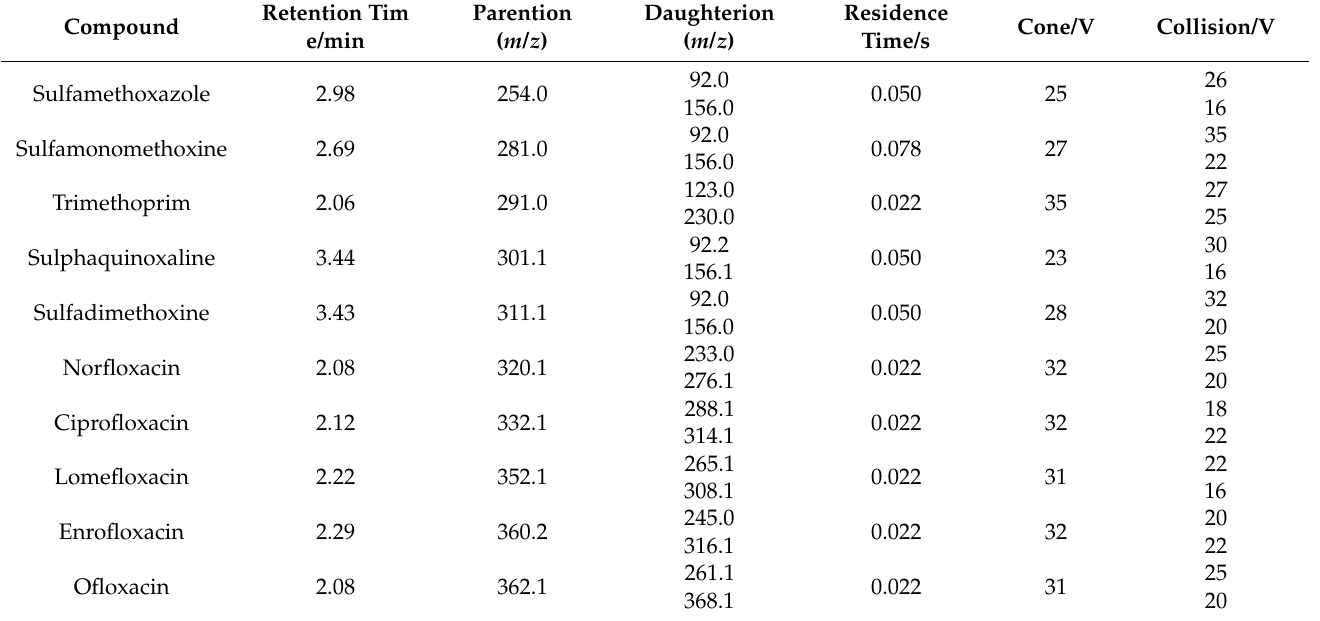
Table 1. MS parameters used in the determination of the ten